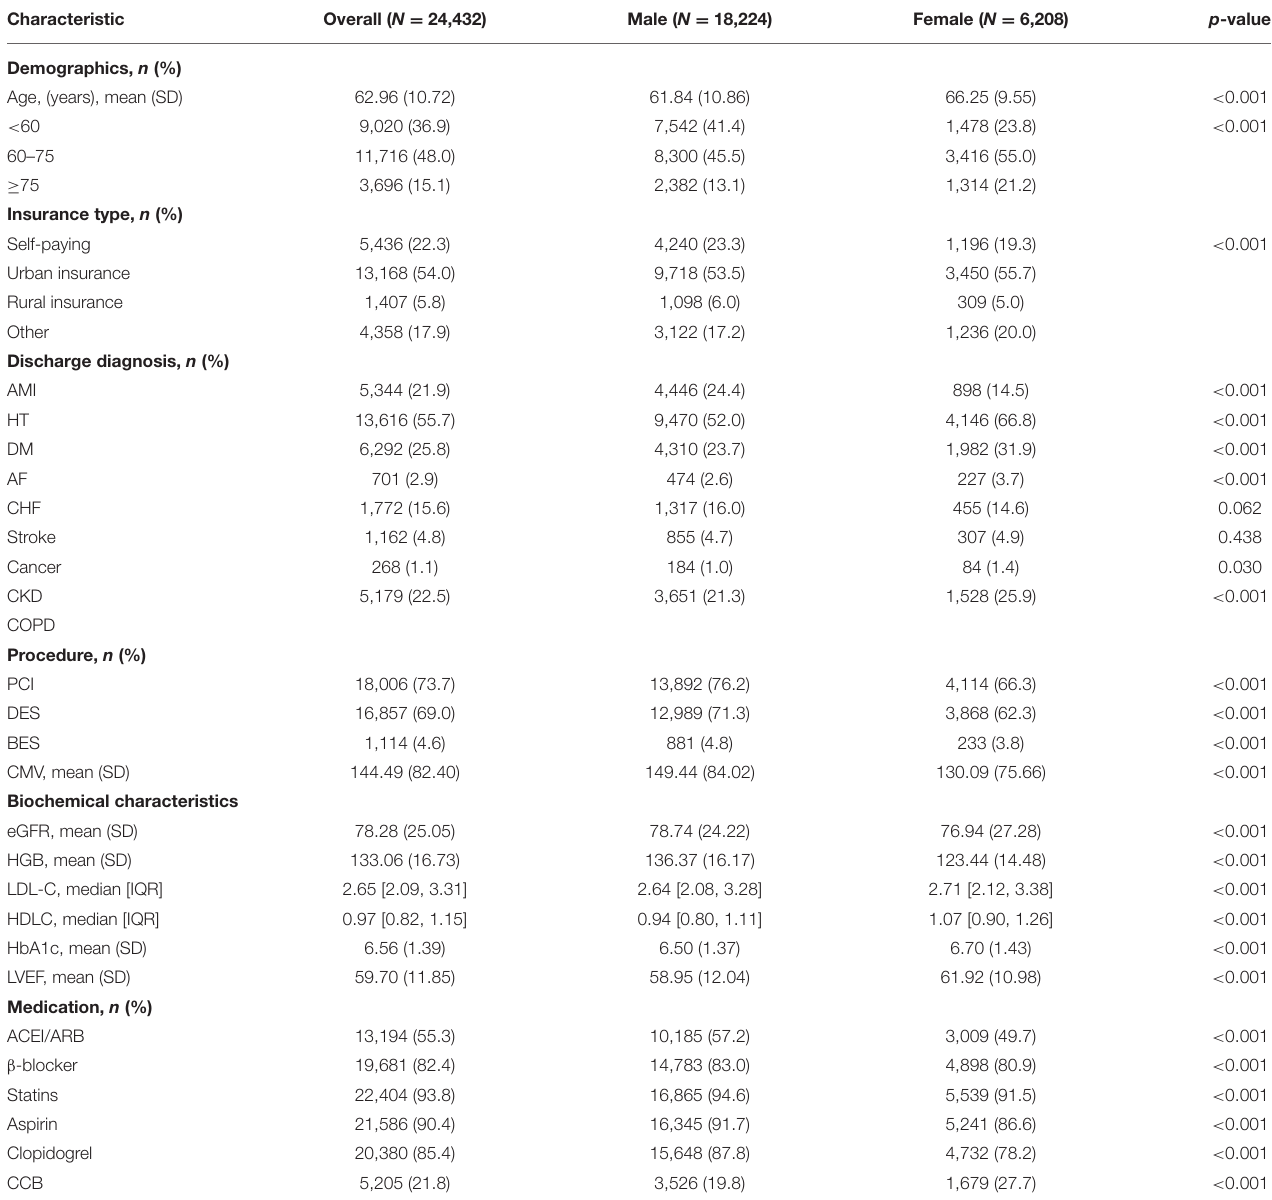
TABLE 1 | Clinical and biochemical characteristics of patients with CAD stratified by male and female. Characteristic Overall ( N = 24,432) Male ( N = 18,224) Female ( N = 6,208) p